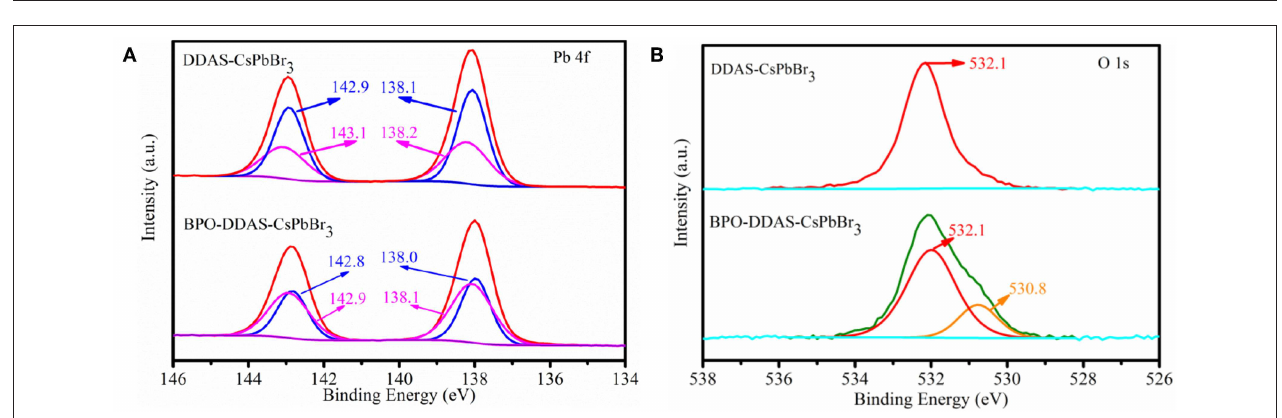
FIGURE 8 | (A) Pb 4f and (B) O 1s XPS spectra of DDAS-CsPbBr 3 NCs and BPO-DDAS-CsPbBr 3